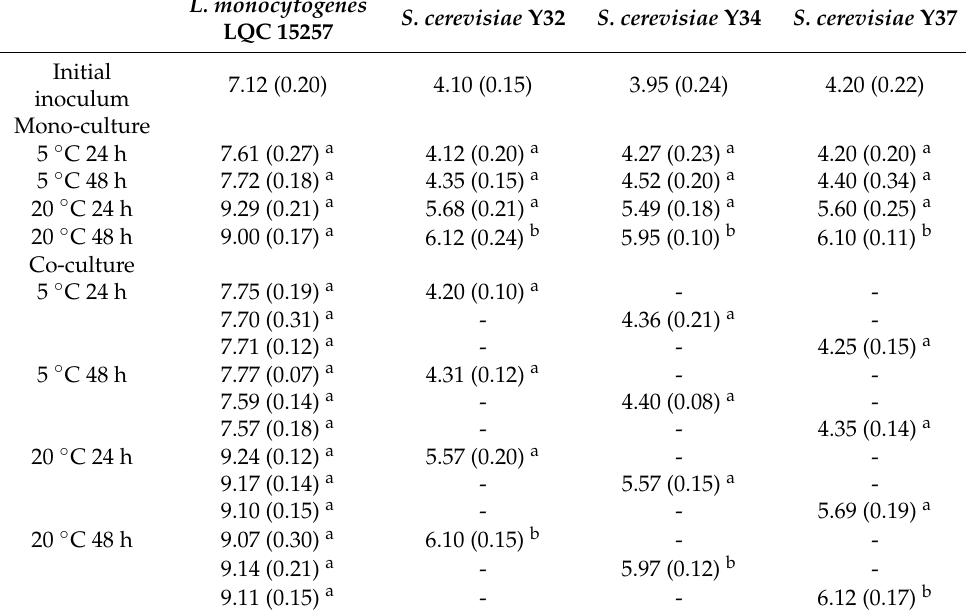
Table 1. L. monocytogenes strain LQC 15257 and S. cerevisiae strains Y32, Y34 and Y37 population dynamics (log CFU/mL) during mono-and co-culture in BHI broth at 5 and 20 ◦ C for 24 and 48